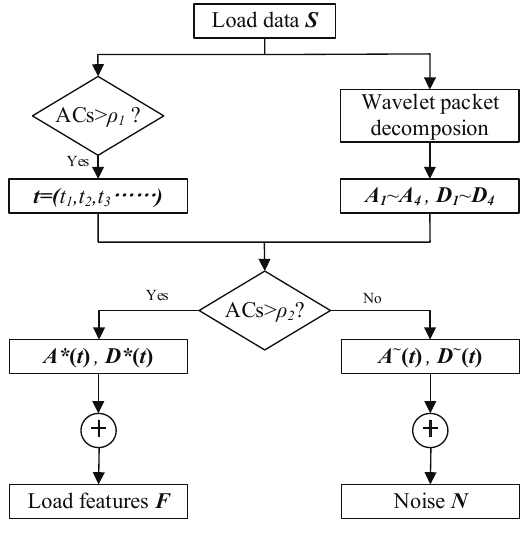
Figure 2. Flowchart of the correction analysis